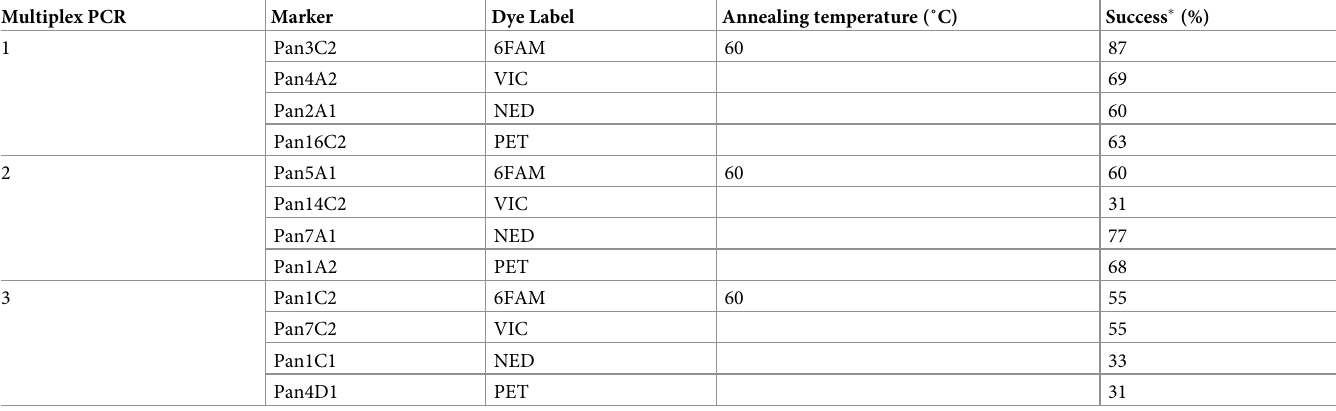
Table 1. Panel of the microsatellite markers proposed for Amur leopard population